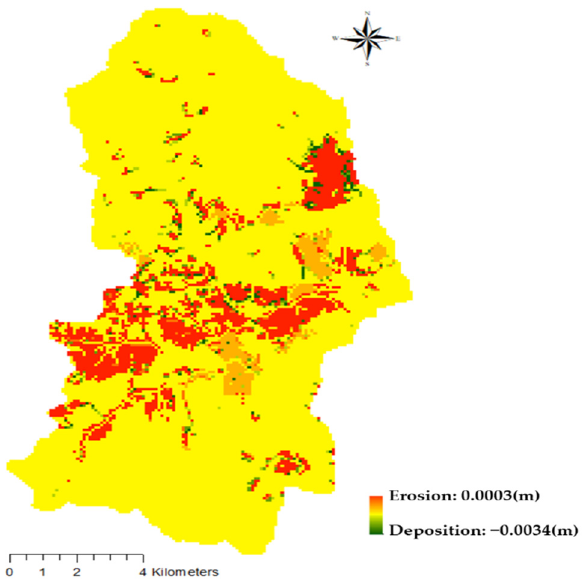
Figure 9. Spatial distribution of net erosion by the MR-SSEM.